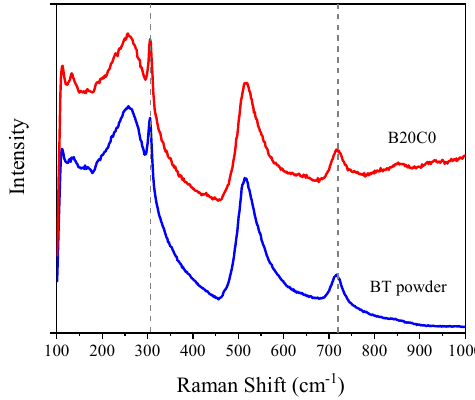
Figure 1. Raman spectra of barium titanate (BT) powder and cellular B20C0 composite.